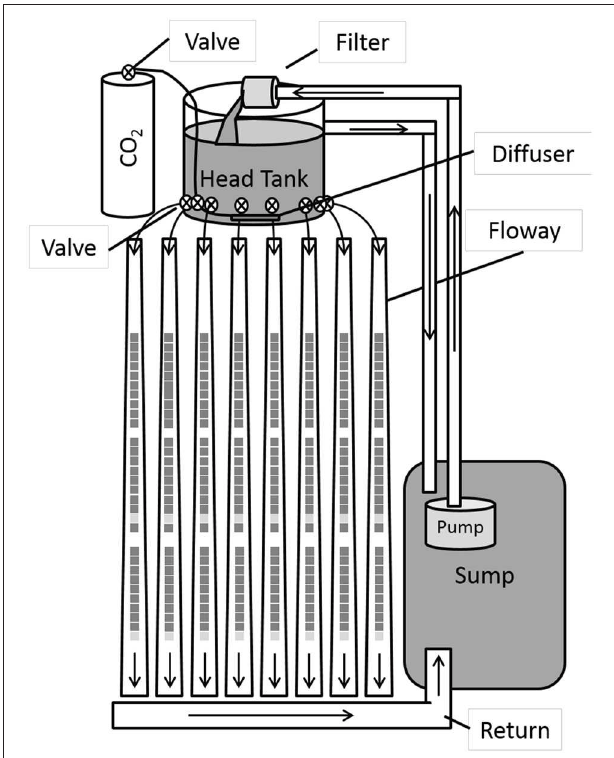
FIGURE 1 | Recirculating wastewater treatment system used to grow filamentous algae. Water was delivered from the constant pressure head tank to each floway before draining to the sump. Floways were made from vinyl gutters (3m long × 10cm wide) and lined with unglazed clay tiles (gray squares). Arrows indicate direction of water flow. Food grade carbon dioxide was infused into the head tank during daylight hours to stimulate algal productivity. Reproduced from Keller and Husted (2015), with permission from the copyright holders, IWA